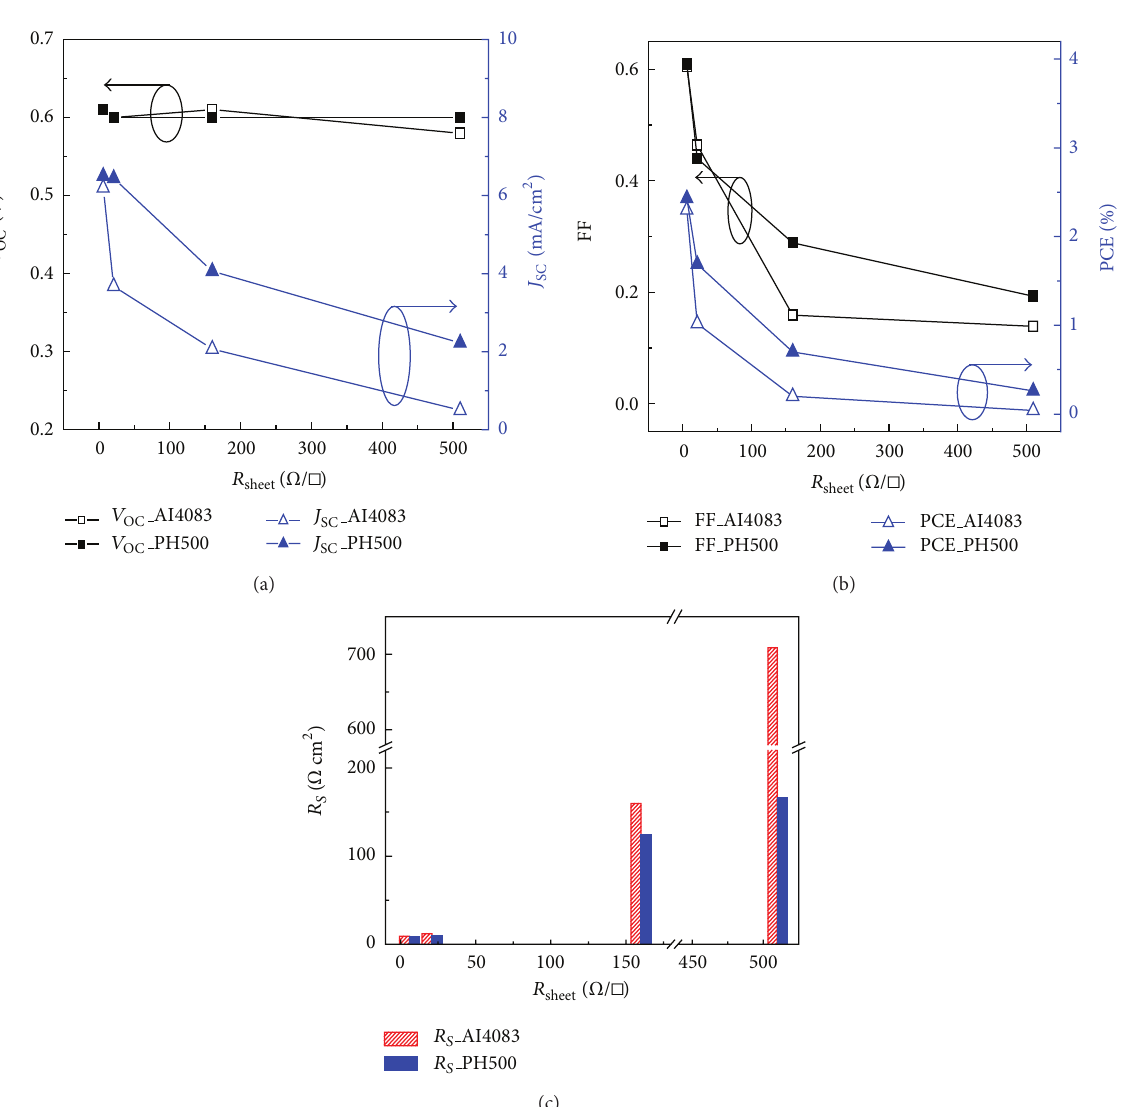
), (b) FF and PCE, and (c) series resistance ( 𝑅 𝑆 ) as a function SC